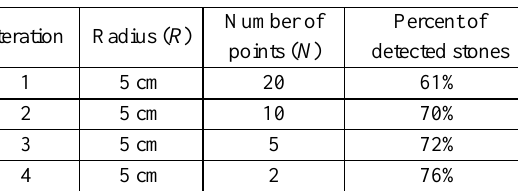
Table 2 . Rocks segmentation results for the test sample 1